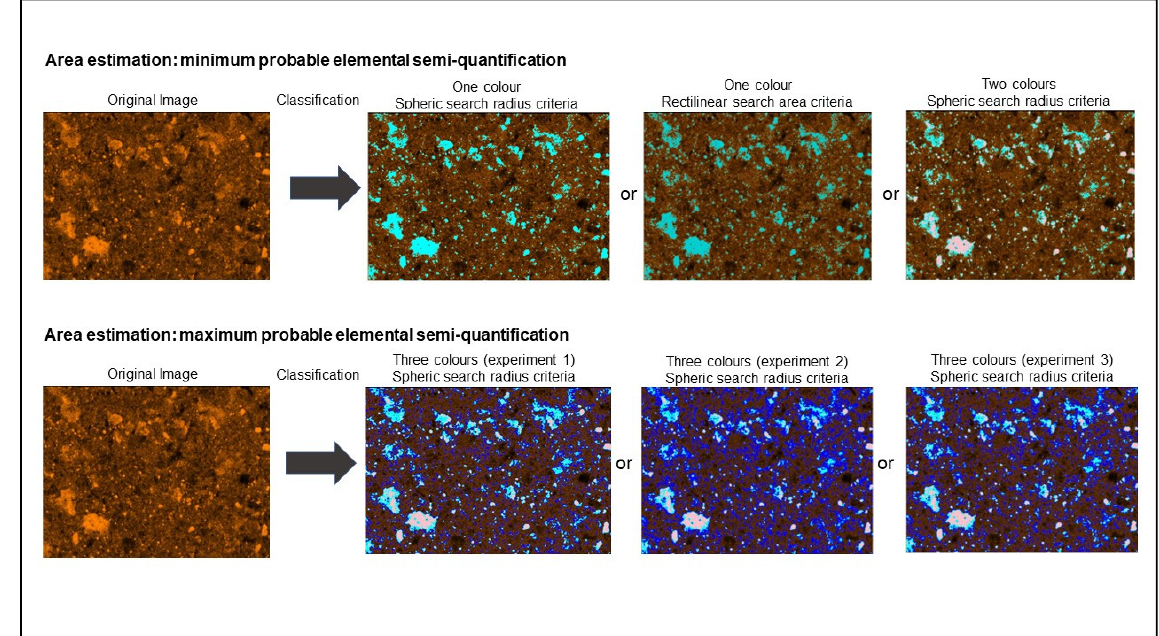
Figure 5. Methodology applied to estimate minimum and maximum probable elemental occurrence in a µ-XRF 2D map (example of element Fe in a bulk pellet sample).